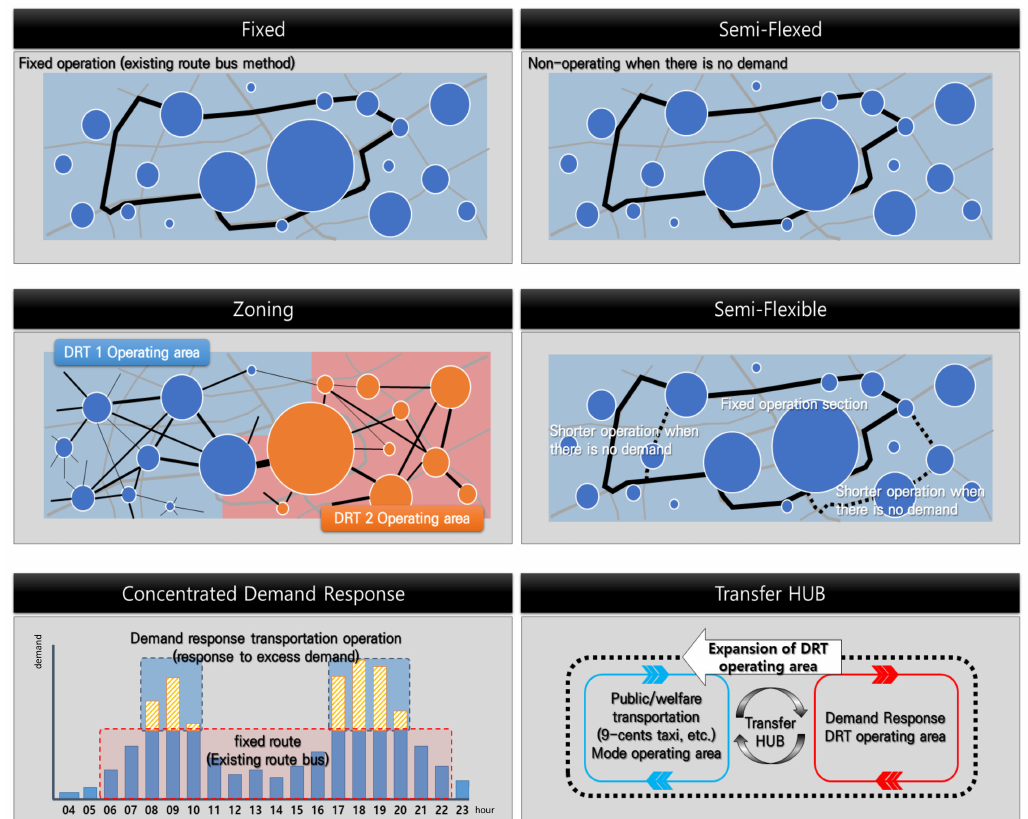
Figure 23. Methods of how to operate DRT means